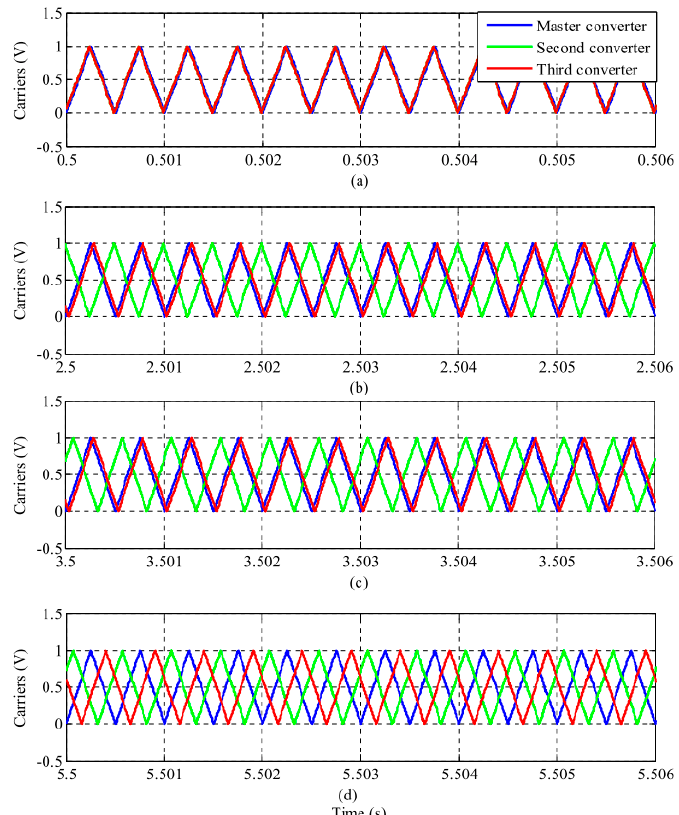
Figure 12. (Case 1) Carriers phase angles for case 1. ( a ) Carriers at t = 0 s; ( b ) Carriers at t = 2.5 s; ( c ) Carriers at t = 3.5 s; ( d ) Carriers at t = 5.5 s.